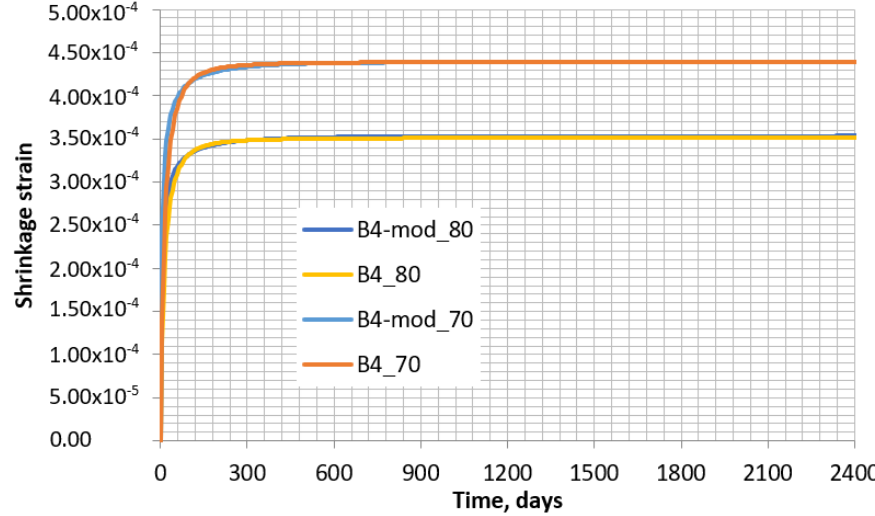
Figure 14. Shrinkage at humidity of 70% and 80% according to B4 model (B4_70 and B4_80, respectively) and modified B4 model (B4-mod_70 and B4-mod_80, respectively) in a 2400-day period.